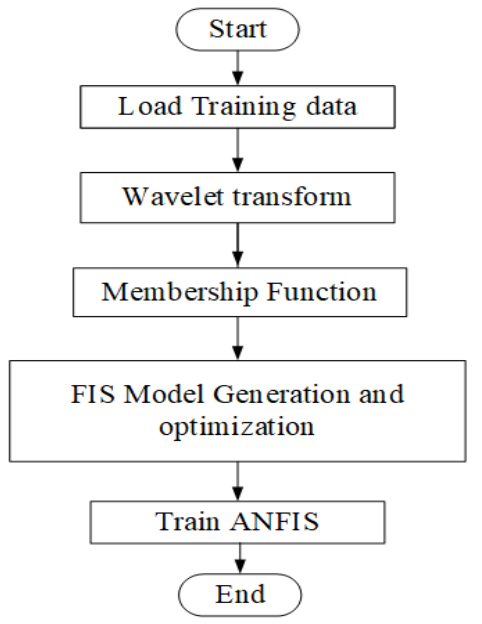
Figure 4. Wavelet-ANFIS training flowchart.